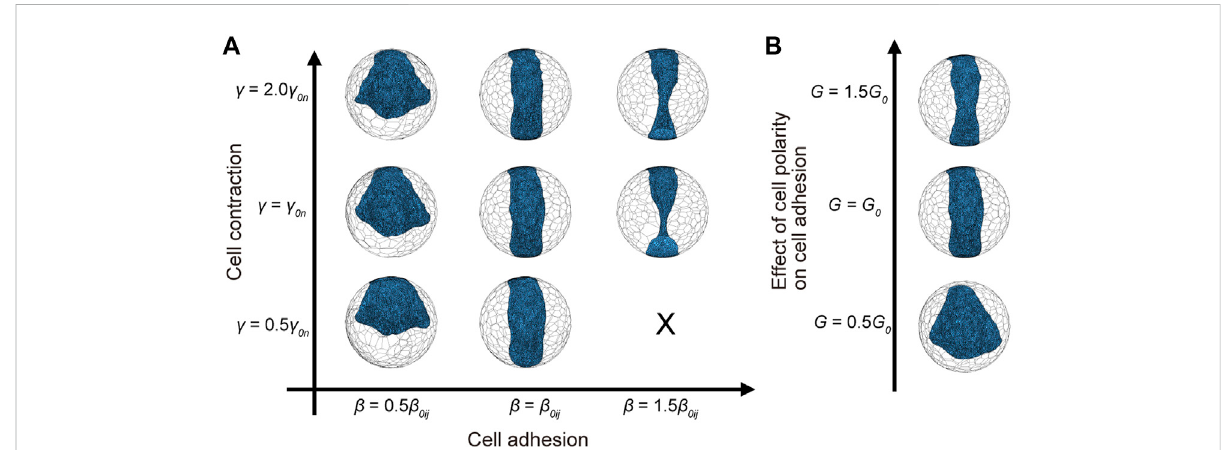
FIGURE 6 Embryo shape as affected by altering cell mechanical parameters. (A) Changing mechanical parameters for cell adhesion β 0 ij in Eq. 7 (horizontal axis) and cell contraction γ n in Eq. 3 (vertical axis). Reference parameters in germ band formation as β 0 ij = 1 μ m and γ 0 n = 0.5 in embryonic cells. In β = 1.5 β 0 ij and γ = 0.5 γ 0 n , the numerical calculation was halted before completion (x symbol). In cell adhesion β = β 0 ij , the widths of germ band at the midpoint were 226 μ m at γ (cid:3) 0 . 5 γ 0 n , 206 μ m at γ (cid:3) γ 0 n , and 180 μ m at γ (cid:3) 2 . 0 γ 0 n . (B) Changing the strength of the effect of cell polarity on cell adhesion G in Eq. 7. Reference parameters in germ band formation as G 0 = 10 in embryonic cells. The blue cells represent embryonic cells, and the colorless cells represent extraembryonic cells in (A,B)